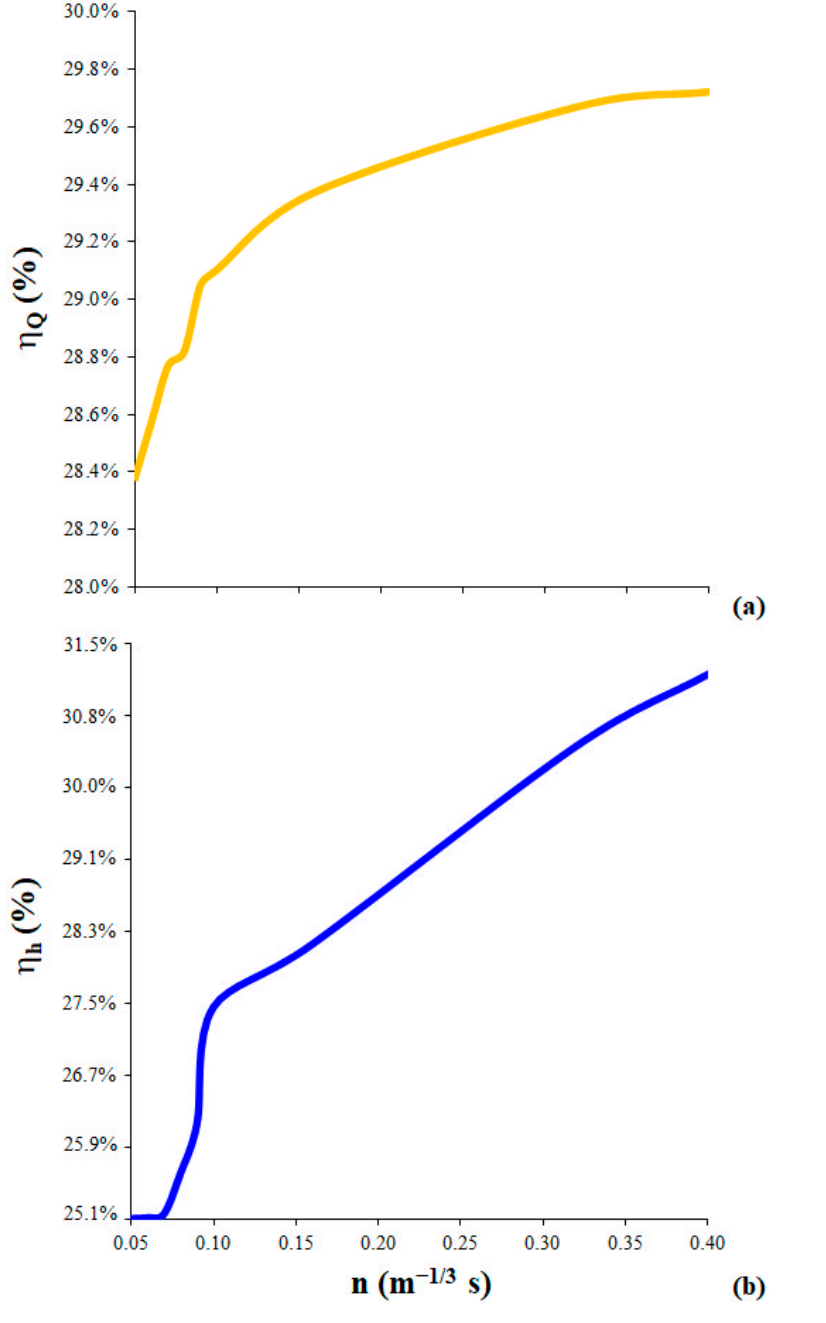
Figure 9. Flood peak ( a ) discharge Q (m 3 s − 1 ) (yellow line) and ( b ) water level h (m) (blue line) reduction efficiencies (in percentage, %) computed at “Bridge B” cross-section of Morra Creek, as a function of Manning’s n ranging between 0.05 m − 1/3 s (no Common reed cover) and 0.40 m − 1/3 s (massive Common reed cover), respectively indicated as η QI (%) and η hI (%).